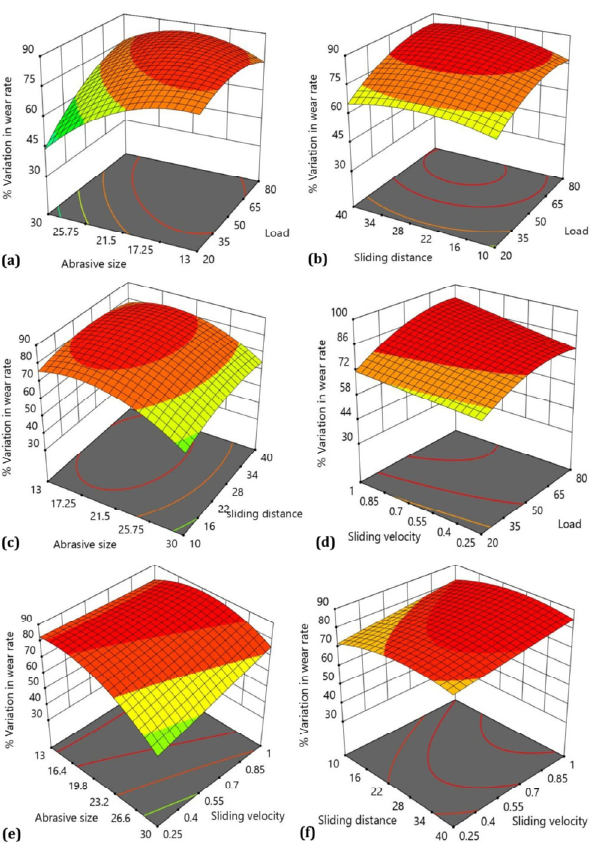
Fig. 8 Surface plots for the ∆ WR with respect to (a) abrasive size ( μ m) and load (N), (b) sliding distance (m) and load (N), (c) abrasive size ( μ m) and sliding distance (m), (d) sliding velocity (m·s − 1 ), and (f) sliding distance (m) and sliding velocity (m·s − 1 ). ∆ WR depicts percentage variation in wear rates between alloy and composite.